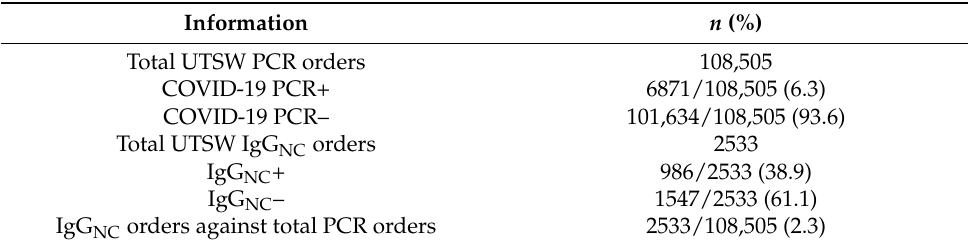
Table 1. Retrospective analysis of the severe acute respiratory syndrome coronavirus 2 (SARS-CoV-2) IgG nucleocapsid assay (IgG NC ) performed in relation to the RT-PCR assay in our health system. COVID-19: coronavirus 2019.